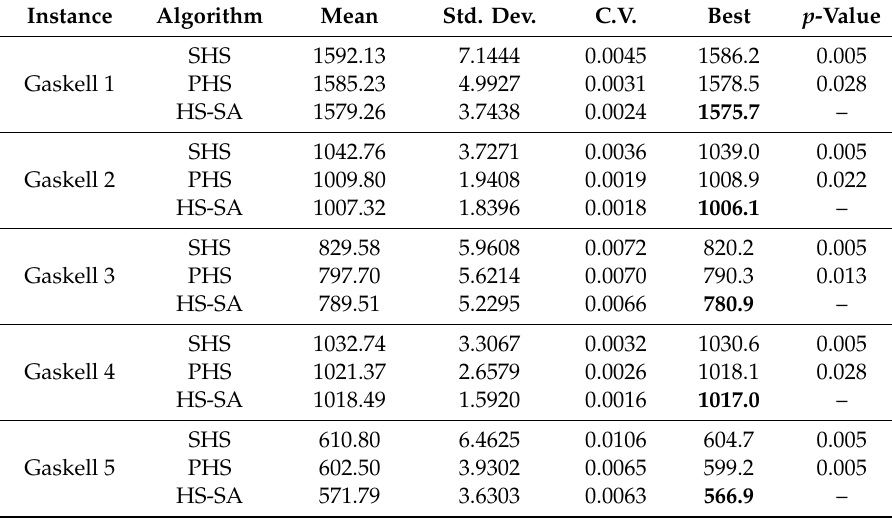
Table 7. Comparative results of Gaskell dataset in LIRP for SHS, PHS, and